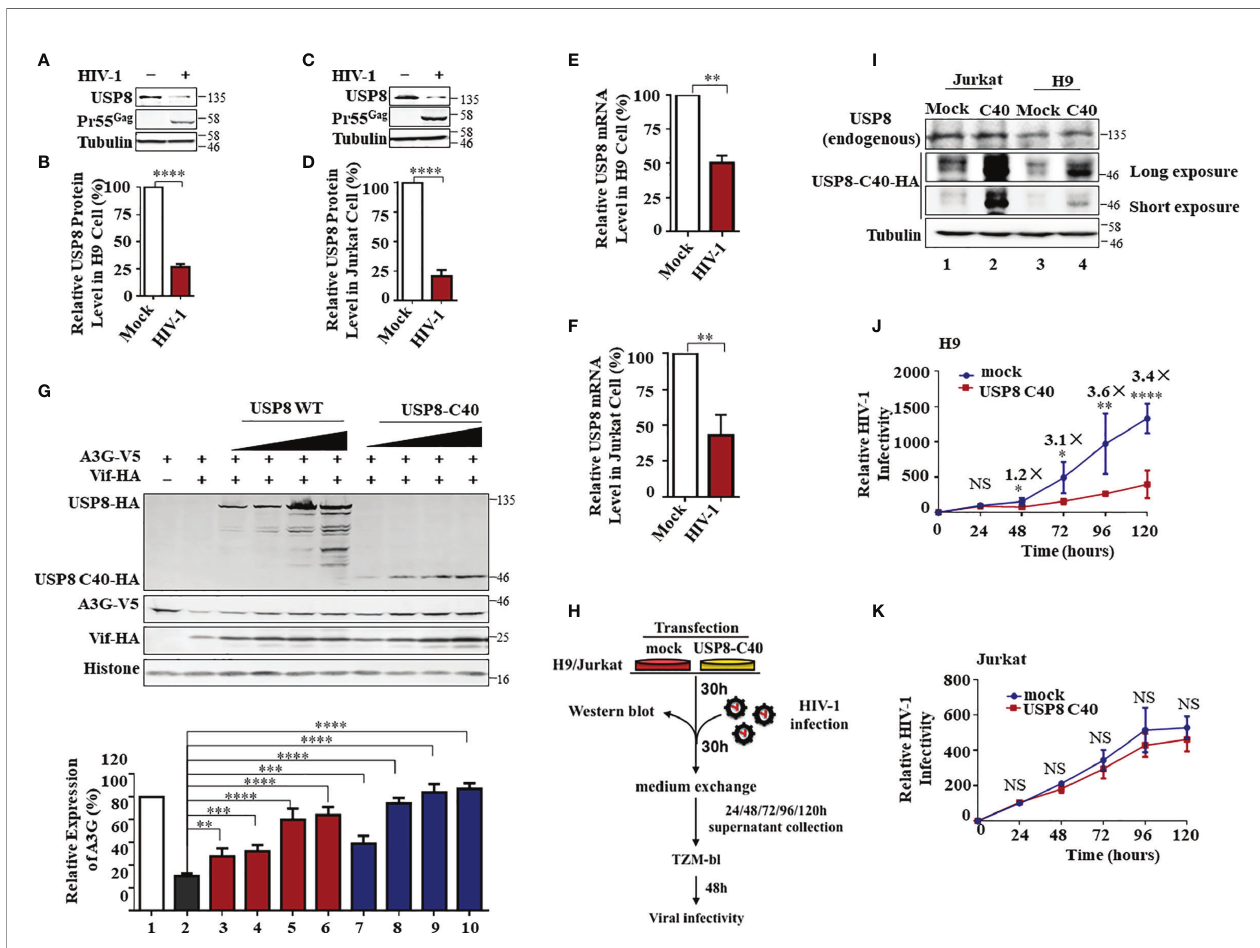
FIGURE 4 | HIV-1 antagonizes ubiquitin-speci fi c protease 8 (USP8) suppression by lowering USP8 protein levels in CD4 + cells. (A – D) HIV-1 suppresses USP8 expression at the protein level. H9 (A) and Jurkat (C) cells were infected or not infected with wild-type (WT) HIV for 48 h. Endogenous USP8 was analyzed by immunoblotting. Virus infection was determined by the presence of Pr55Gag. Tubulin was used as a loading control. USP8 expression was measured by ImageJ2X (mock infection was set to 100%) (B, D) . (E, F) HIV-1 suppresses USP8 expression at the mRNA level. H9 (E) and Jurkat (F) cells were infected or not infected with WT HIV for 48 h. USP8 mRNA expression was detected by RT-qPCR. Glyceraldehyde 3-phosphate dehydrogenase (GAPDH) was used as a control. (G) Comparison of the effect of full-length USP8 and C40-truncated USP8 on virion infectivity factor (Vif)-mediated apolipoprotein B mRNA-editing enzyme catalytic polypeptide-like 3 (APOBEC3)G (A3G) degradation. A3G-V5, together with Vif-HA or its control vector, was transfected into HEK293T cells in the presence of increasing amounts of full-length USP8 or C40-truncated USP8. Cells were harvested after 48 h, and cell lysates were heated with lysis buffer, then immunoprecipitated with the corresponding antibodies. Quanti fi cation of A3G expression was analyzed by ImageJ2X. A3G expression alone was normalized to 100%. (H) Work fl ow for USP8 C40 inhibition of HIV infectivity in H9 and Jurkat cells. (I) USP8-C40-HA or control vector was electro-transfected into H9 (I) or Jurkat (J) cells. After 30 h, USP8 and USP8 C40-HA expression was analyzed by immunoblotting. (J, K) USP8 C40-HA or control vector was electro-transfected into H9 (K) or Jurkat (L) cells. After 30 h, H9/Jurkat cells were infected with WT HIV for another 30 h. The cells were then washed three times with phosphate buffered saline (PBS) and placed in fresh RPMI-1640 medium with 10% fetal bovine serum (FBS). Cell supernatants were then harvested after 24, 48, 72, 96, and 120 h of infection. Virus infectivity was assessed using TZM-BL indicator cells. Means and standard deviations are presented. Panels (B, D – F, J, K) are results from n =